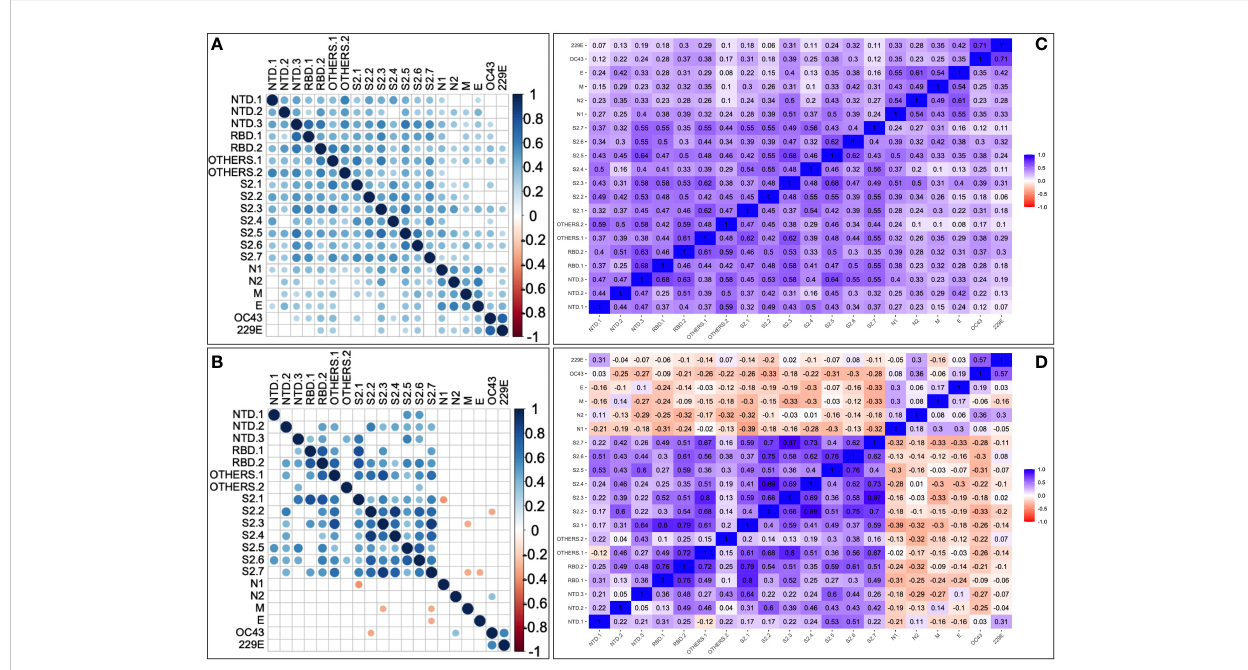
FIGURE 3 Pairwise correlation between SARS-CoV-2 and HuCoV-directed IFN- g . Depicts correlation plots of all examined SARS-CoV-2 and human coronavirus peptide pools for 68 HIV-negative (A) and 36 HIV-positive (B) specimens using Spearman's rank correlation test. Blue dots represent a positive correlation, while red dots represent a negative correlation. The darker the circle, the stronger the correlation, and the lighter the circle, the weaker the correlation. The correlation matrices show correlation coef fi cients between peptides in HIV-positive (C) and HIV-negative (D) specimens using Spearman's rank correlation. P-values of 0.05 or less are considered signi fi cant. Non-signi fi cant correlations are indicated by blank